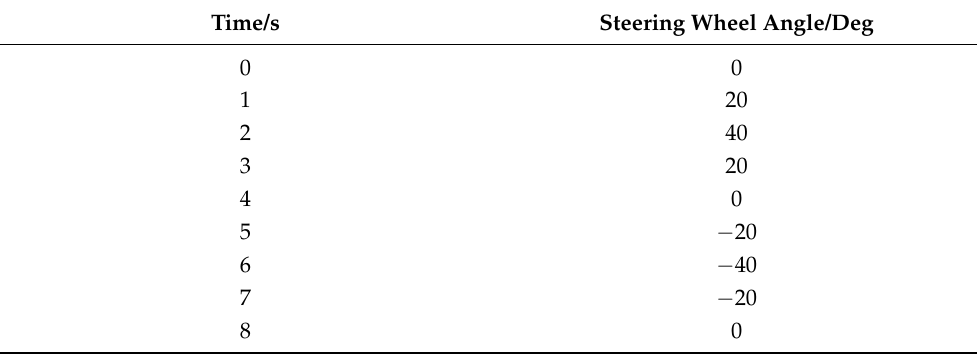
Table 1. Racing steering wheel angle